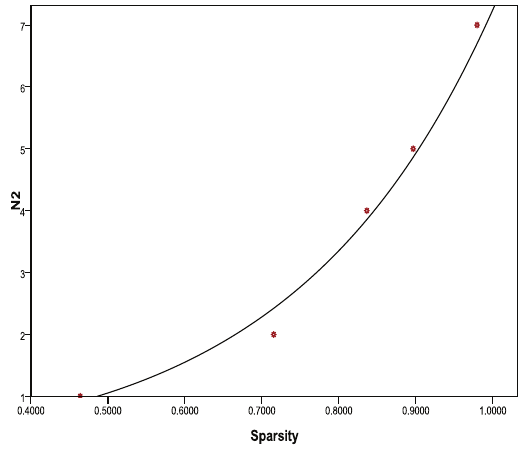
Table 10. Determine the optimal value of